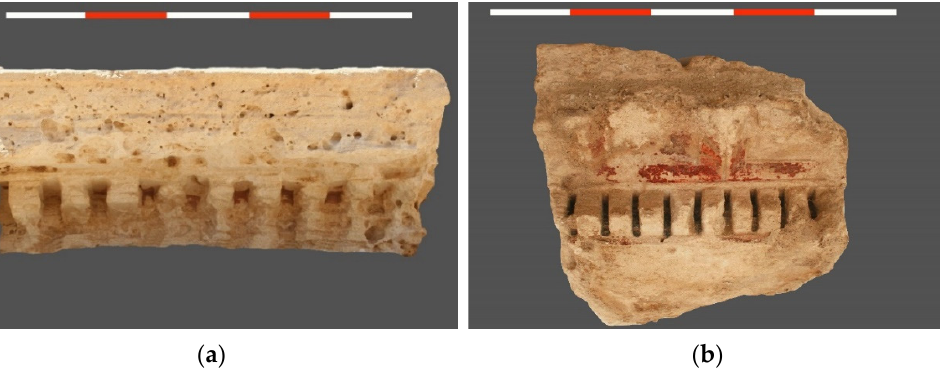
Figure 6. Fragments of cornices with preserved traces of polychrome: ( a ) element of Ionic cornice from house H10 with traces of Pompeian red between the dentils; ( b ) fragment of a cornice from house H1 with flat grooved modillions painted red and dentils with traces of black (photos Rafał Czerner).